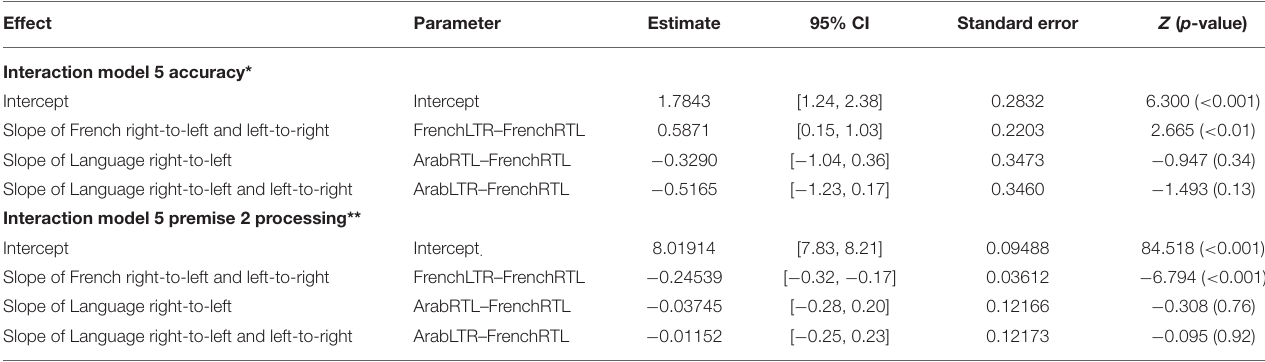
TABLE 7 | Parameters estimates of the interaction of model 5 for Accuracy and the interaction of model 5 for Premise 2 processing time.